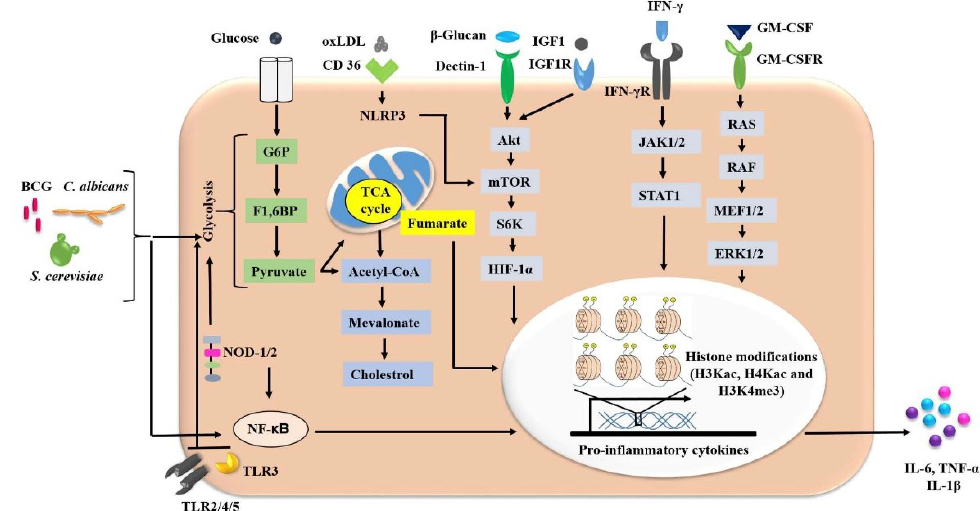
Figure 2. The signaling pathways that operate in trained immunity. The exposure of innate immune cells to various stimuli initiates the trained immunity pathways. Interaction or exposure with mi- croorganisms (BCG, C. albicans, S. cerevisiae ), endogenous/soluble stimuli (GM-CSF, IFN- γ , β -glucan, oxLDL, IGF1, lipoproteins), or PAMPs with surface/cytosolic receptors leads to metabolic shifts and epigenetic modifications in these innate immune cells. This initiates a series of signaling cascades and increases the secretion of pro-inflammatory cytokines. Intermediates of these signaling pathways (Akt-mTOR-HIF-1 α , JAK/STAT, RAS, NF- κ B) regulate the genetic machinery through acetylation and methylation processes. Activation of glycolysis and deposition of fumarate (TCA cycle) and mevalonate (cholesterol synthesis) play important roles in the induction of trained immunity. TLR (Toll-like receptor), NOD (nucleotide-binding oligomerization domain), oxLDL (oxidized low density lipoprotein), IGF1 (insulin-like growth factor1), IGF1R (insulin-like growth factor1 receptor), mTOR (mammalian target of rapamycin), JAK (Janus kinase), STAT (signal transducer and activator of transcription), GM-CSF (granulocyte monocyte-colony stimulating factor), IL (interleukin), TNF- α (tumor necrosis factor- α ), HIF-1 α (hypoxia inducing factor-1 α ), G6P (glucose 6-phosphate), F1,6-BP (fructose 1, 6 bisphosphate), TCA (tricarboxylic